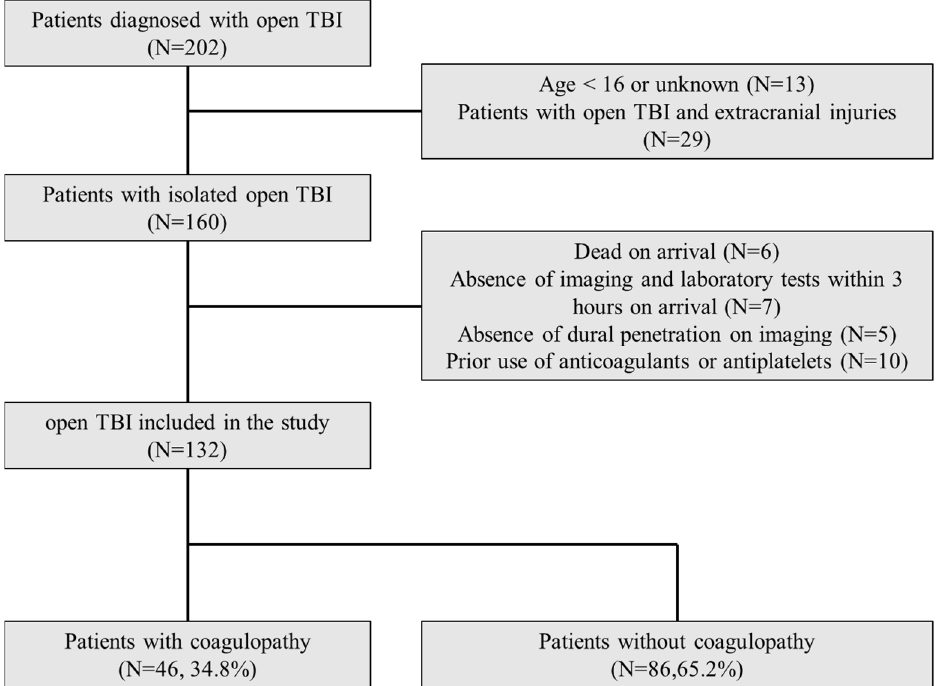
Figure 1. Flow chart of patient selection. TBI: traumatic brain injury.